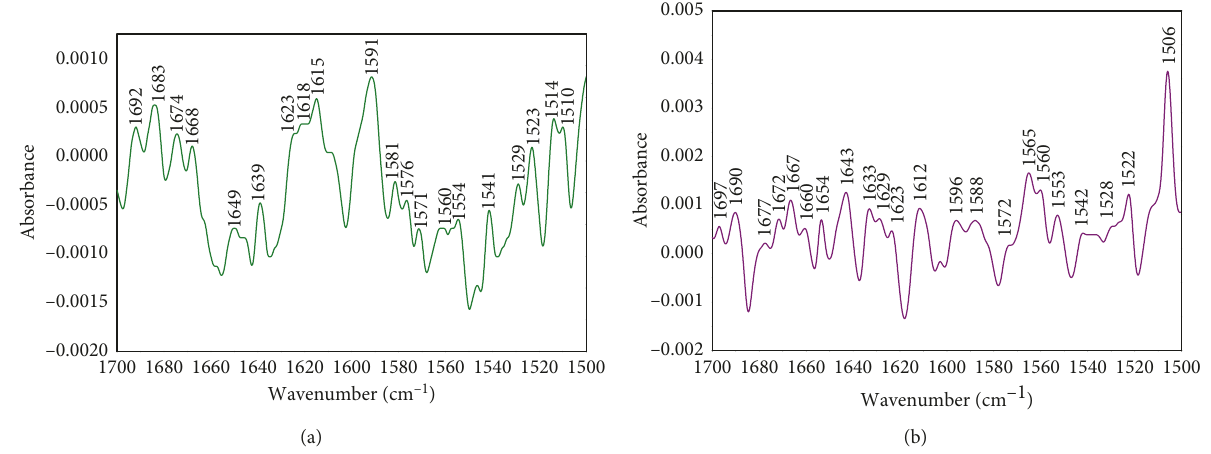
Figure 8: FT-IR spectra at 1700–1500cm − 1 at 297K and pH 7.40. (a) Free BSA after subtraction from buffer and (b) bound BSA with RSN after subtraction from RSN and buffer. Concentration of BSA and RSN were kept constant at 3 . 5 × 10 − 6 mol · L − 1 . Table 4: FT-IR spectral position peaks of free BSA and after interaction with RSN at 297K and pH 7.40. Amide I (cm − 1 ) System